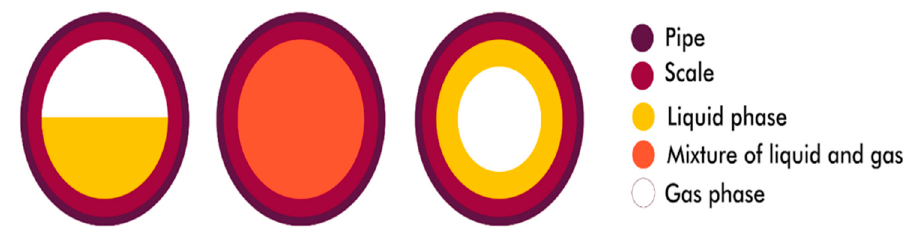
Figure 3. Simulated flow regimes from left to right: stratified, homogeneous, and annular, respec- tively.